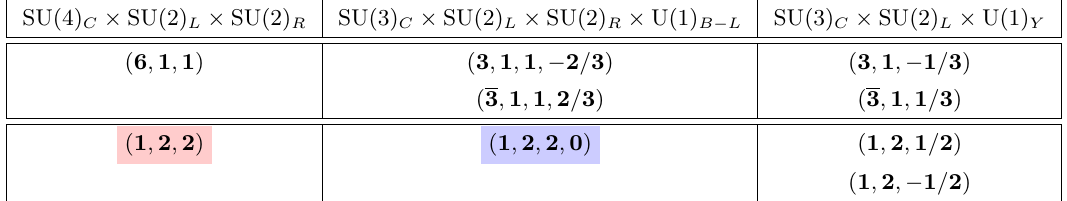
Table 7 . Decomposition of 10 -Higgs, which is a real field. Multiplets highlighted in red, blue, and green contribute to the RGE running of the gauge coupling in the energy scale in between SO(10) and G 422 , G 422 and G 3221 , and G 3221 and G 321 , respectively. Multiplets highlighted in gray represent the Goldstone bosons.